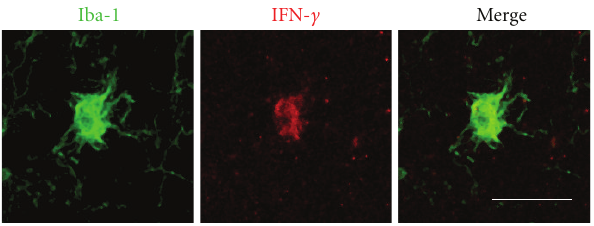
Figure 3: Activated microglial cells express IFN- γ in Parkinsonism: confocal images of the immunofluorescence of IFN- γ (red) com- bined with microglia cells marker—Iba-1 (green) in the SNpc of a parkinsonian monkey. Scale bar: 35